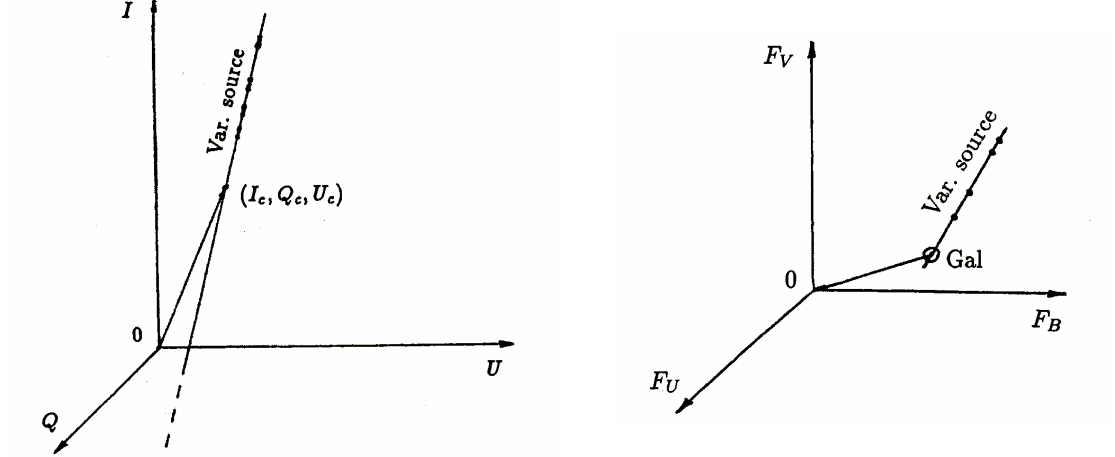
Figure 1. Polarization behaviour in space of absolute Stokes parameters ( left ) and photometry behaviour in three-dimensional flux space ( right